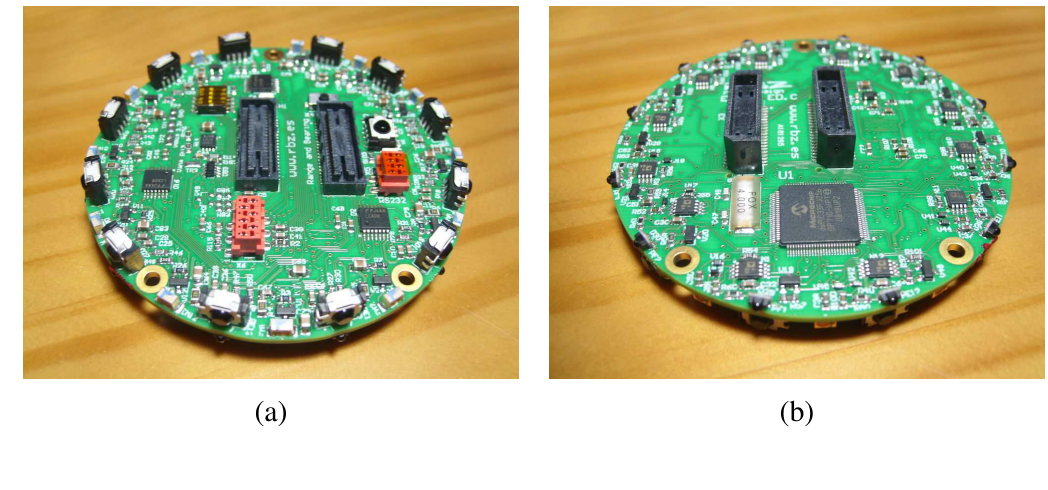
Figure 1. (a) Top and (b) bottom view of the range and bearing board.